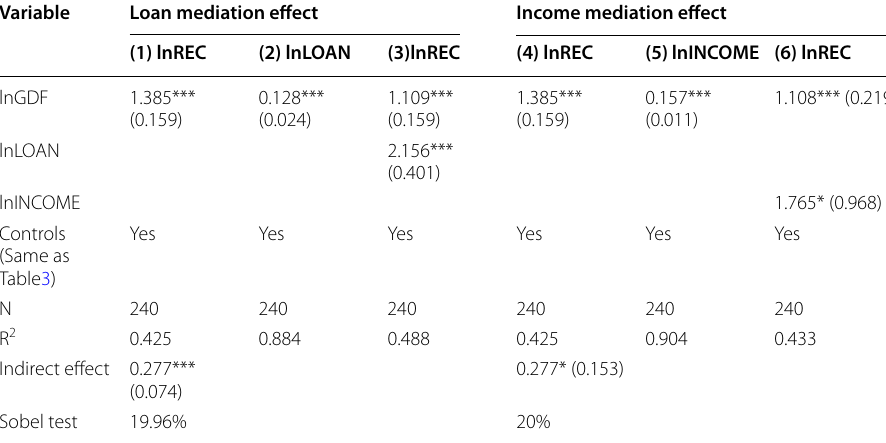
Table 4 Mediation